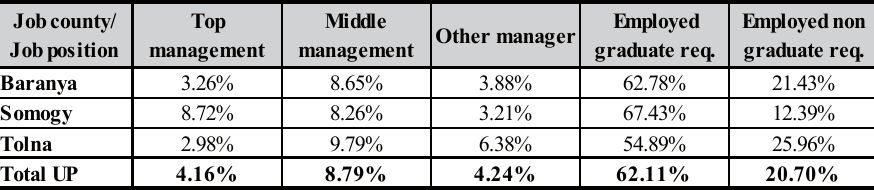
Table 3. The graduates’ distribution in the South-Transdanubian region by the job position (n=1,251).